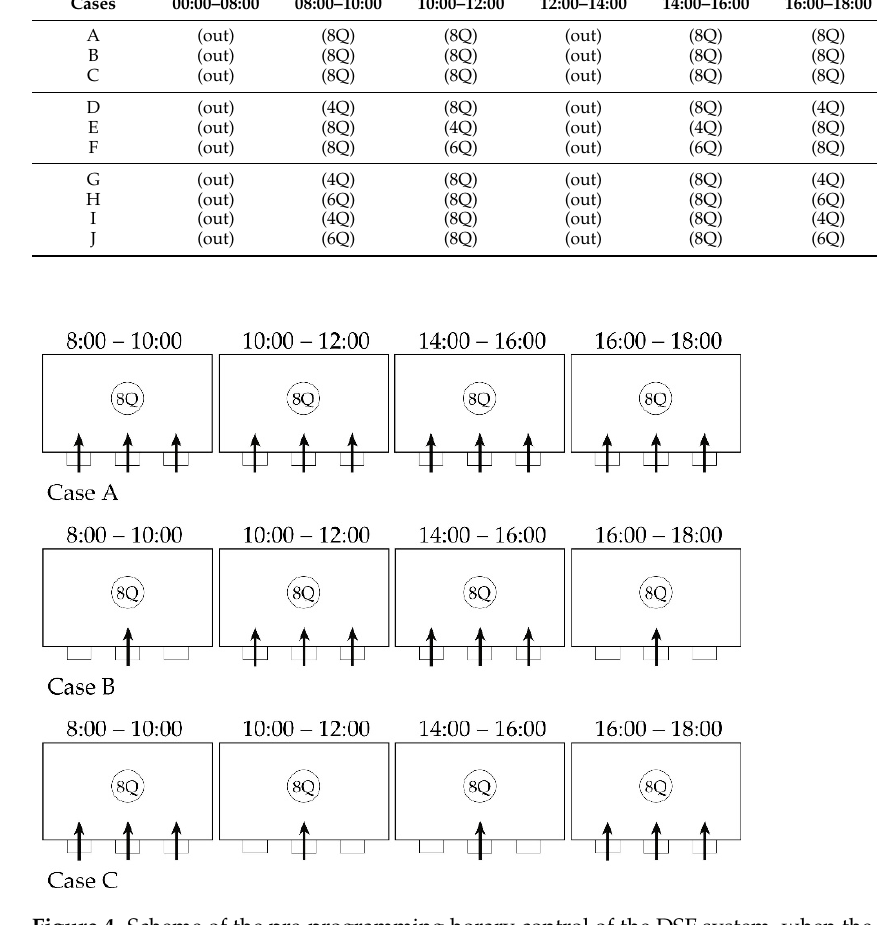
Figure 4. Scheme of the pre-programming horary control of the DSF system, when the airflow rate is constant and the number of DSF to operate is variable.